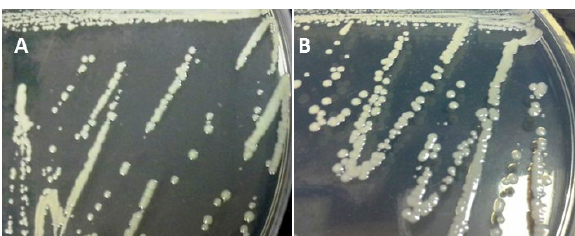
Figure 3. Identical colony morphologies of the parental stain Agrobacterium fabrum C58 (A) and the mutant (B) after 48 h of growth in nutrient agar medium.